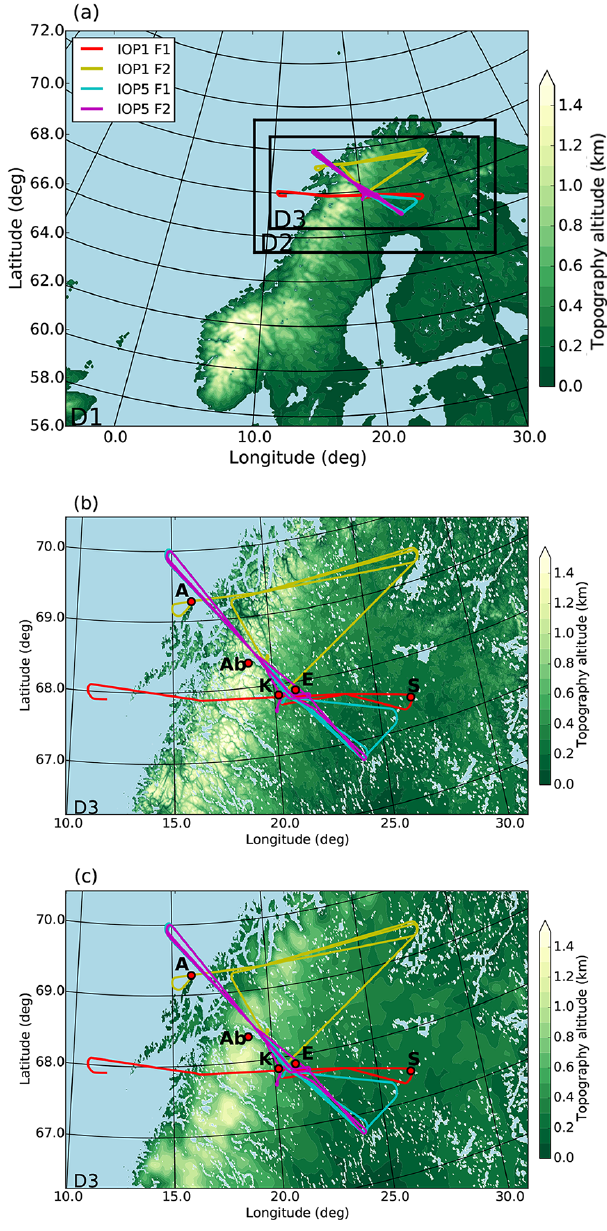
Figure 1. Topographic maps of Scandinavia and operational ar- eas of the GW-LCYCLE I campaign. The coloured lines indicate DLR Falcon flight tracks during IOP1 and IOP5. In panel (a) the region shown and the black boxes mark the modelling domains for mesoscale WRF simulations with horizontal grid sizes (cid:49)x of 7.2km (D1), 2.4km (D2) and 0.8km (D3). The topography of do- main D3 is shown in panel (b) for the CTRL and in panel (c) for the SMTOPO simulations (see Table 2). The red dots mark the po- sition of Andenes (A), Abisko (Ab), Kiruna (K), Esrange (E) and Sodankylä